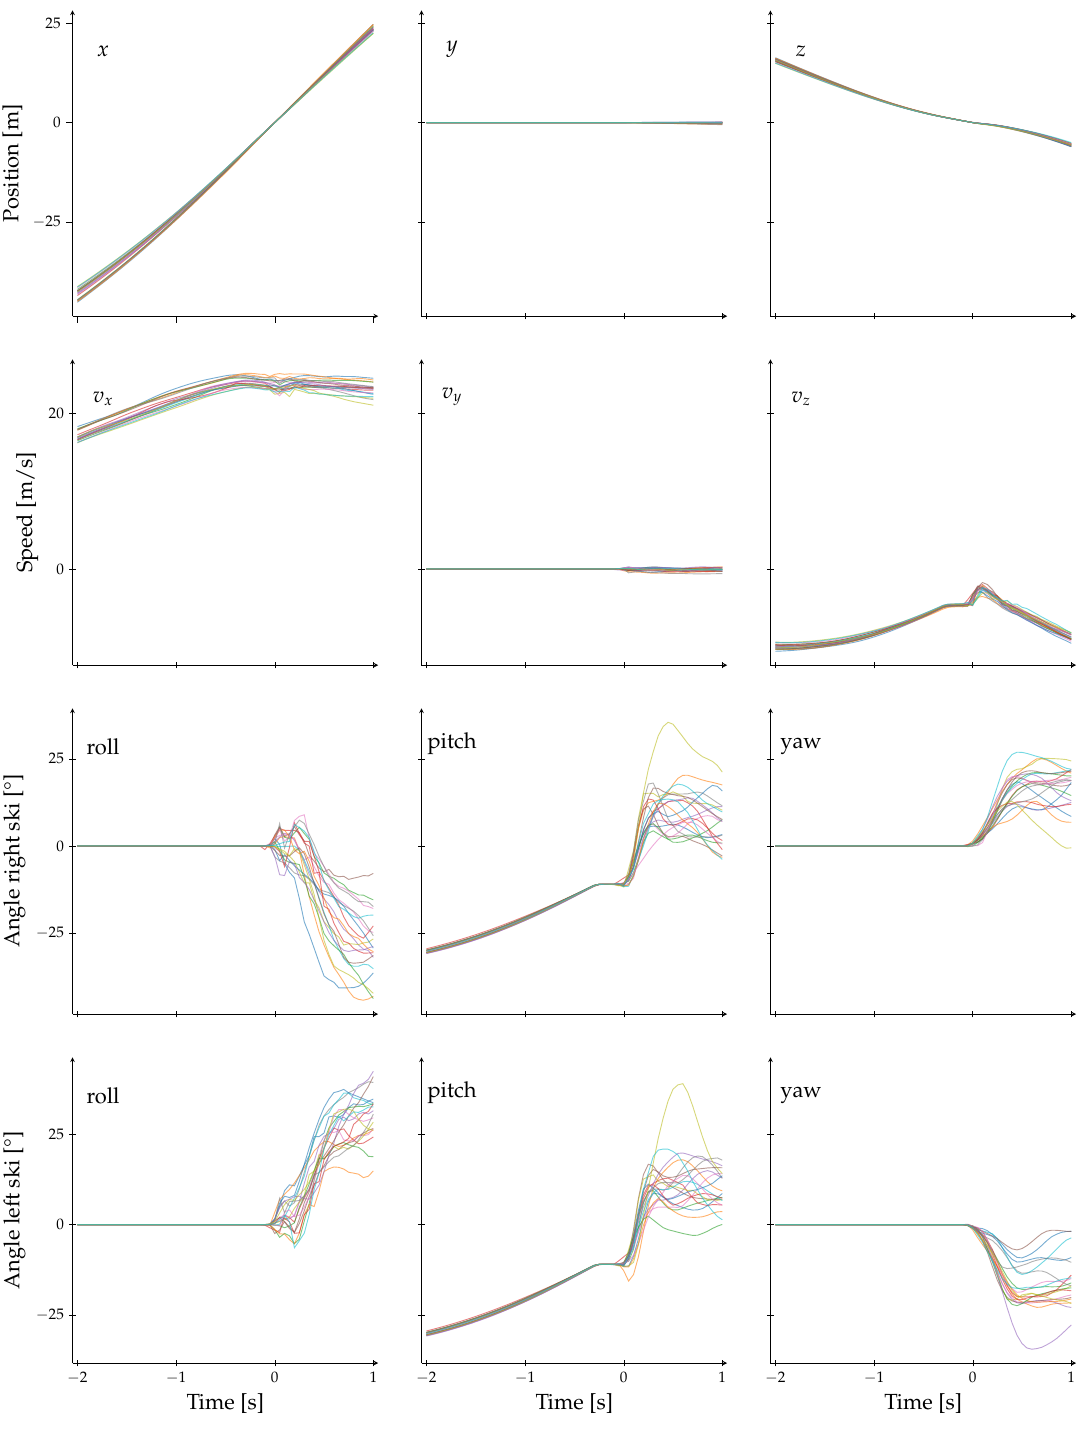
Figure 3. Example data for 20 ski jumps. The figure shows the 3D position, 3D velocity, and the skis’ orientation. The x-axis of the subplots is shared along the columns and the y-axis along the rows.